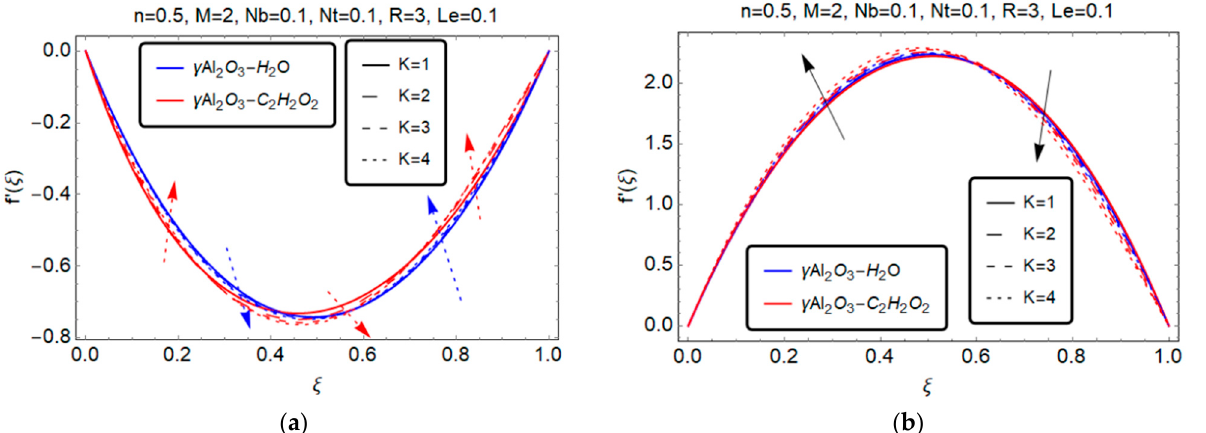
Figure 3. Effect of micropolar parameter 𝐾 on 𝑓′(𝜉) . ( a ) S > 0; ( b ) S < 0.